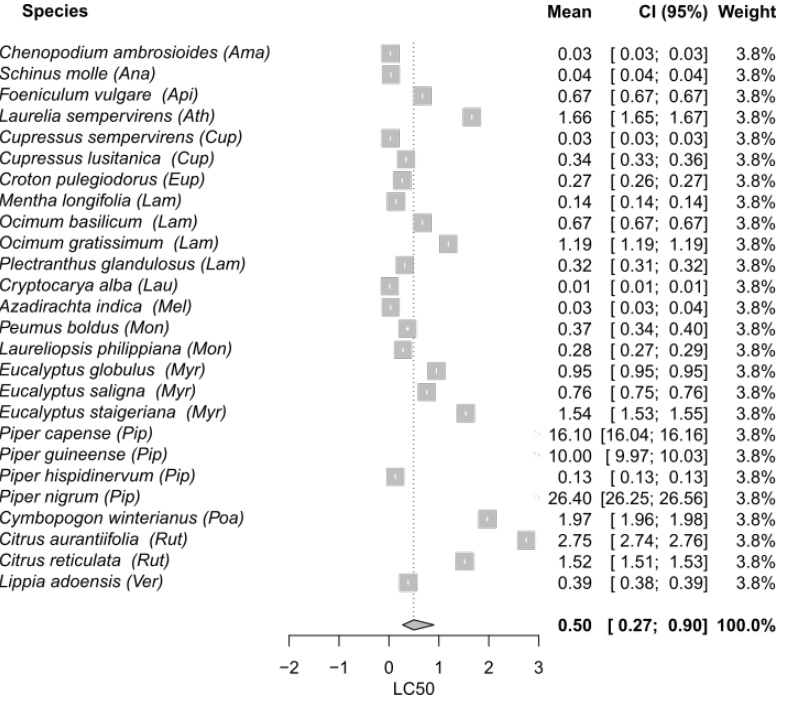
Figure 4. Meta-analysis on the contact toxicity of EOs against S. zeamais through maize grains impregnation. Single LC 50 means and the LC 50 global mean are represented along with their corresponding 95% confidence intervals. The abbreviations are as follows: Amaranthaceae (Ama), Anacardiaceae (Ana), Apiaceae (Api), Atherospermataceae (Ath), Cupressaceae (Cup), Euphorbiaceae (Eup), Lamiaceae (Lam), Lauraceae (Lau), Meliaceae (Mel), Monimiaceae (Mon), Myrtaceae (Myr), Piperaceae (Pip), Poaceae (Poa), Rutaceae (Rut), Verbenaceae (Ver).